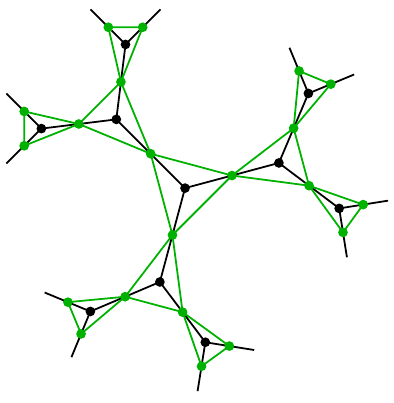
Figure 1 . A regular graph in black, and its line graph in